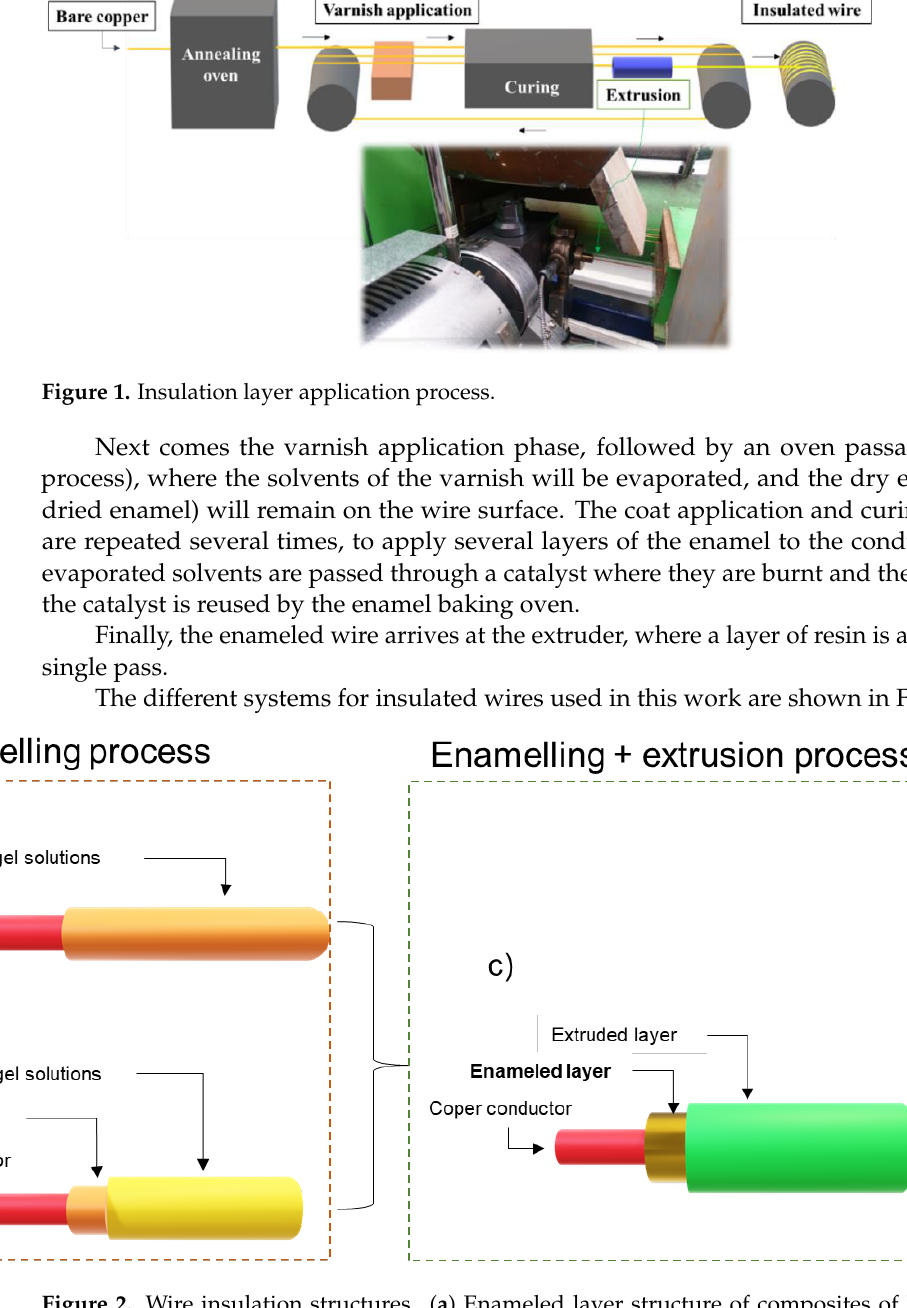
Figure 1. Insulation layer application process.